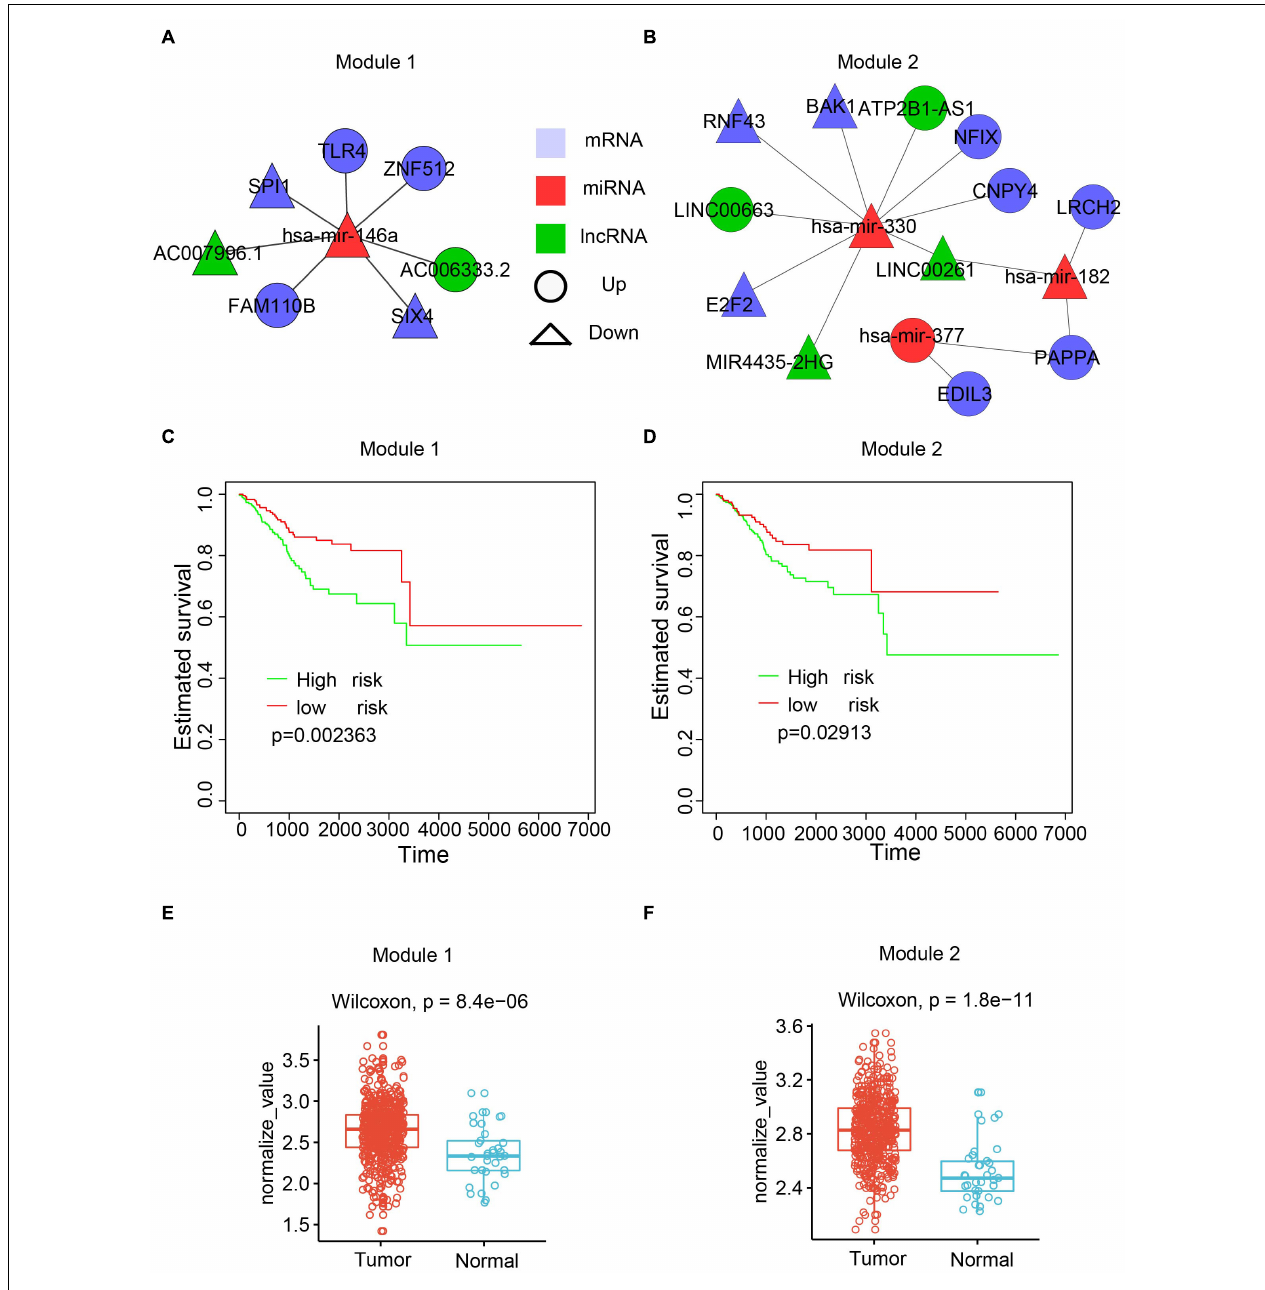
FIGURE 7 | Functional modules identified from the dysregulated network. (A) The first module. (B) The second module. (C) Kaplan-Meier plot of survival for the first module. (D) Kaplan-Meier plot of survival for the second module. (E) Expression patterns of the first modules in normal and cancer samples. The average expression value of each molecule crossing all normal/cancer samples was used. (F) Expression patterns of the second modules in normal and cancer